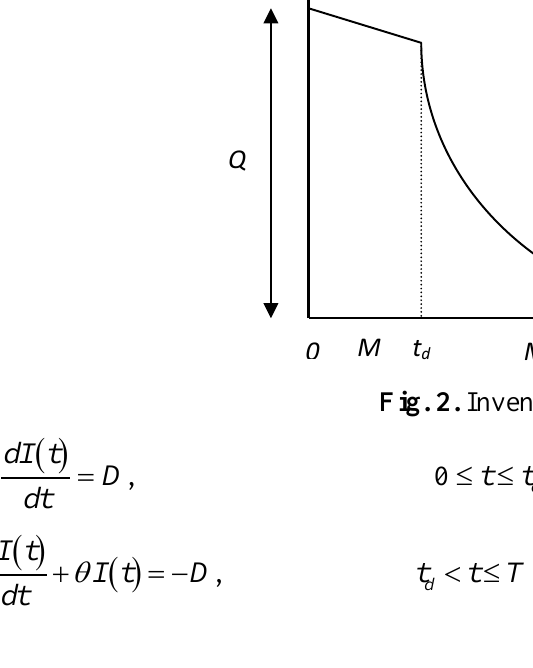
Fig. 2. Inventory level at any